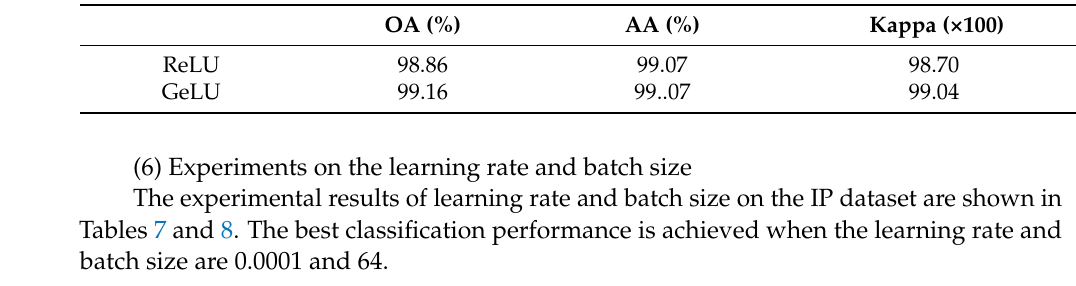
Table 6. Comparison results using ReLU and GeLU in Res-SEConv module on the IP dataset.